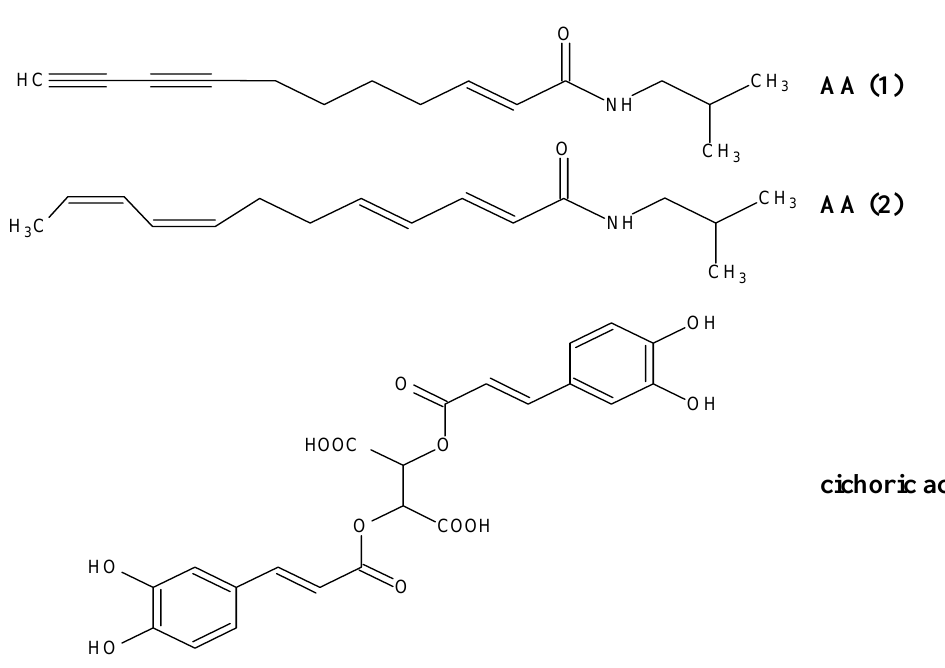
Figure 2: Effects of chinacea and its components on LPS-induced NF-kB expression levels in macrophages. Data are expressed as mean ± SEM for n = 3; * significantly different from LPS only stimulated cells where p<